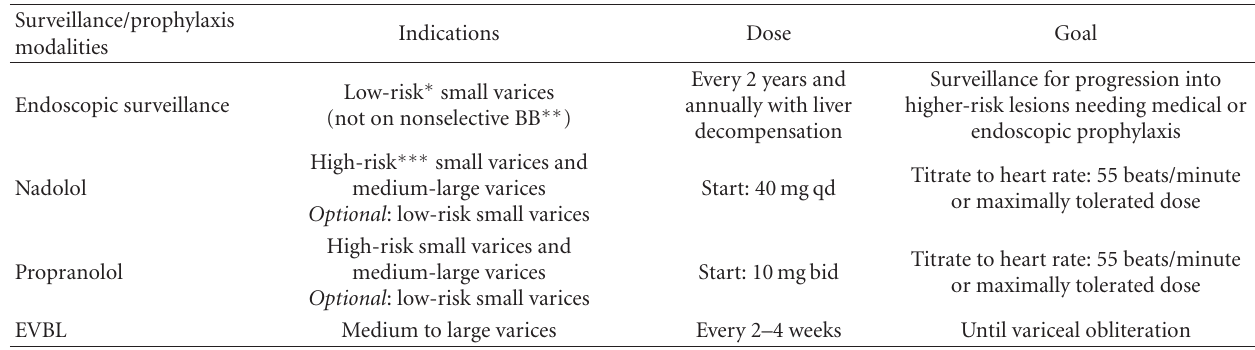
Table 1: Primary prophylaxis and